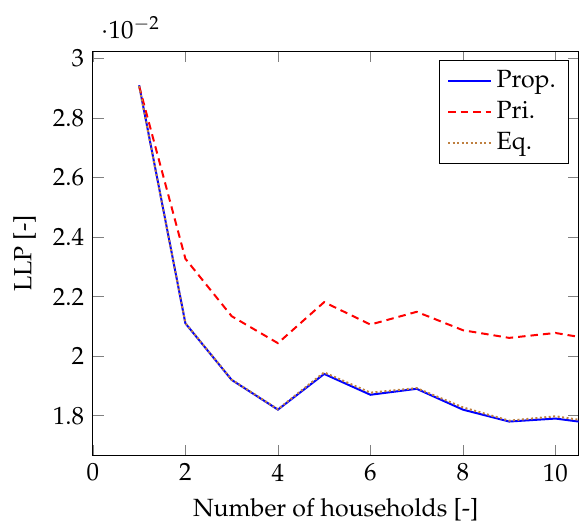
Figure 11. Performance comparison of the 3 excess energy-based battery charging methods in terms of LLP for varying homogeneous (tier 5) microgrid sizes. The 3 methods are proportional (Prop.), priority (Pri.), and equal (Eq.) energy sharing